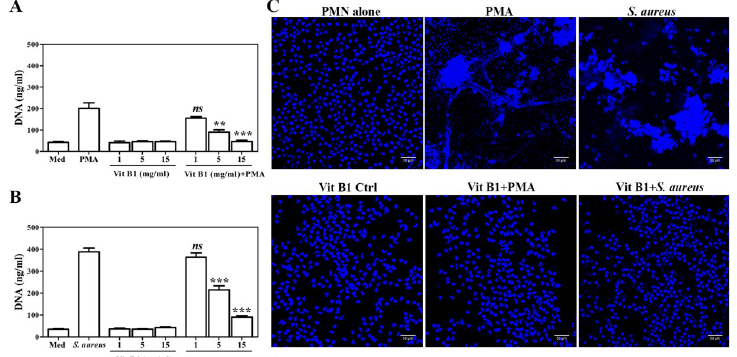
Fig 4. The reduction of NET releases by pretreatment with vitamin B1. Different concentrations of vitamin B1 were added into isolated PMNs at 37˚C for 30 min. (A) 100 nM PMA or (B) S . aureus at a MOI of 10 were then added in the cultures at 37˚C and 5% CO 2 for 90 min. The DNA supernatants were quantified as described above. The data shown are representative of four independent experiments (n = 4). The horizontal line denotes mean ± SEM. �� p < 0.01, ��� p < 0.001, and NS-non significant. (C) The effect of vitamin B1 on the release of NET formation by fluorescent images, the cultures were fixed with 4% PFA and then stained with DAPI. The confocal images illustrated controls and stimulated PMNs with PMA or S . aureus after 15 mg/ml vitamin B1 pretreatment. Photomicrographs are of representative cells from three independent experiments. Magnification: 10 × or 20 × ; scale bars: 50 μ